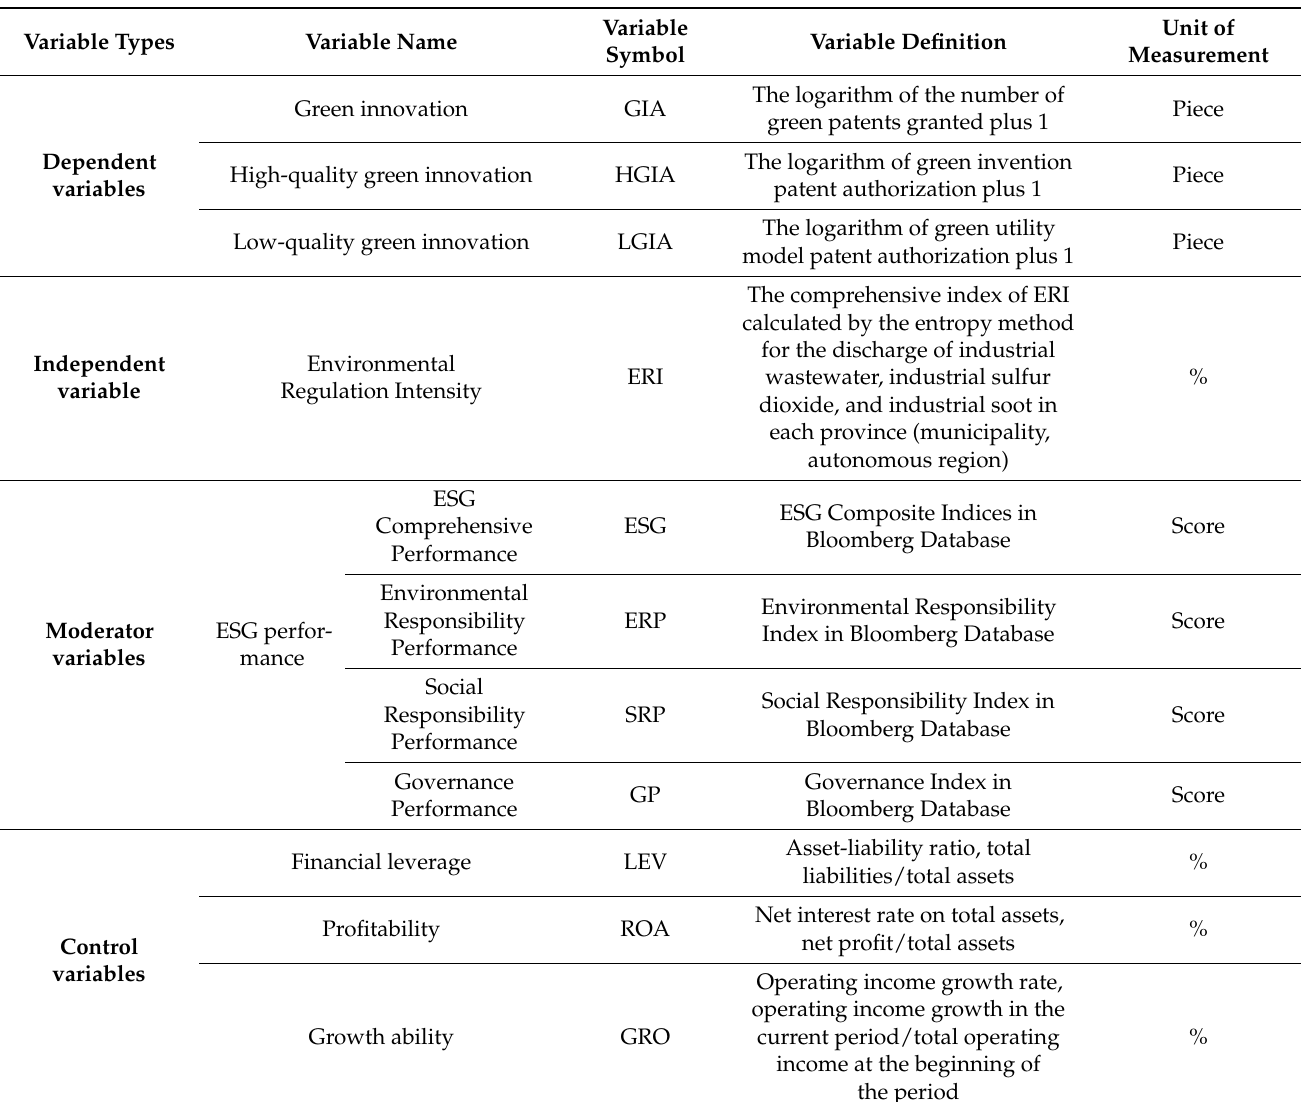
Table 2. Definition of main